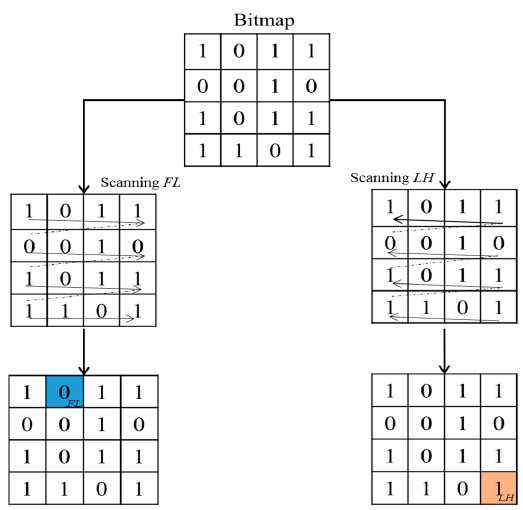
Figure 4. The example of FL and LH scanning.